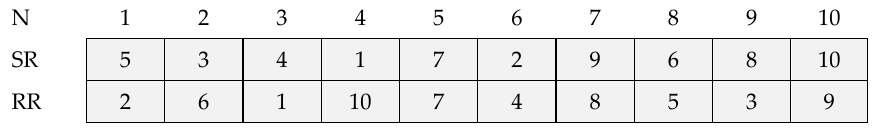
Figure 4. The representation of sequences of storage requests (SRs) and retrieval requests (RRs).